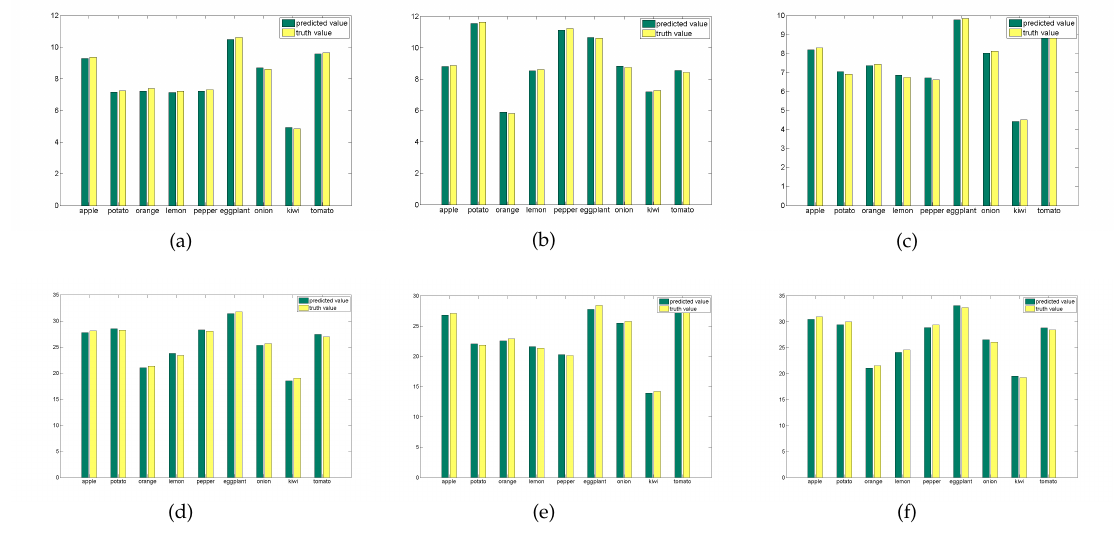
Figure 10. Comparison of predicted and measured values of many kinds of fruit models. The phenotypes include length, height, width, x -axis perimeter, y -axis perimeter, and z -axis perimeter, recording as ( a – f ). ( a ) Comparison of length values. ( b ) Comparison of height values. ( c ) Comparison of width values. ( d ) Comparison of x -axis perimeter. ( e ) Comparison of y -axis perimeter. ( f ) Comparison of z -axis